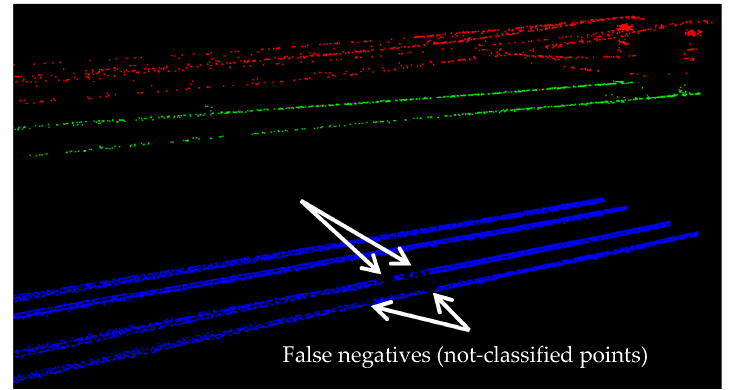
Figure 16. False negatives (not-classified points) in the rail tracks classification results are indicated by arrows. This is due to the presence of an external object on the rail track.